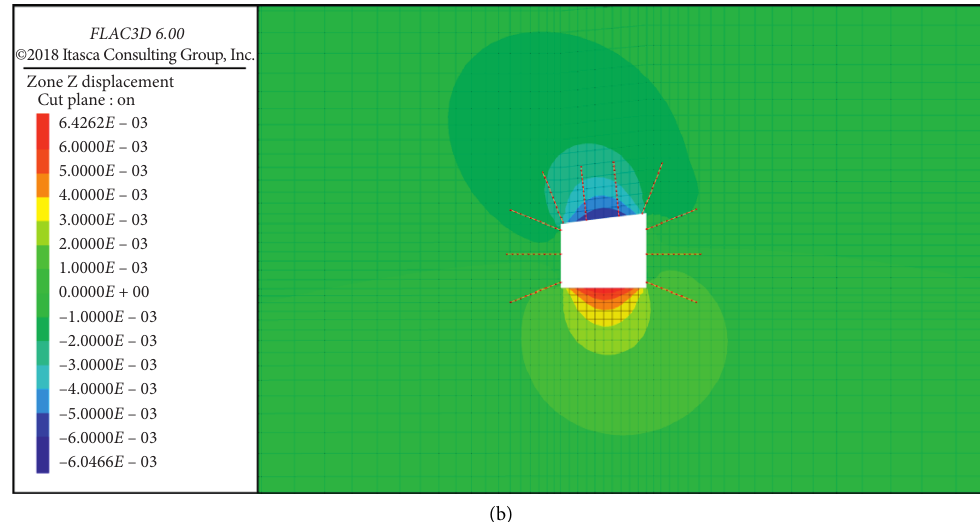
Figure 7: Sinking clouds on the roof under different support conditions: (a) original support and (b) reinforced support.